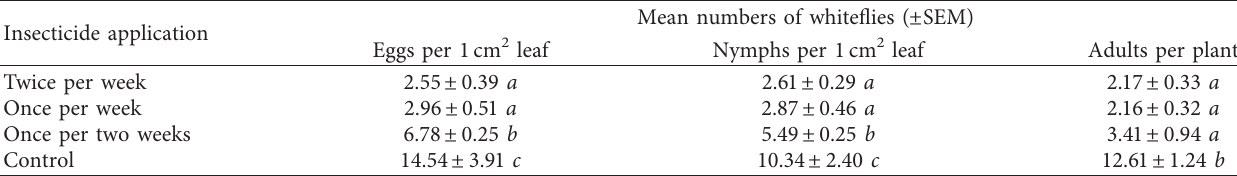
Table 3: Mean numbers of whitefly eggs, nymphs, and adults for insecticide application frequency treatments, 2018. Insecticide application